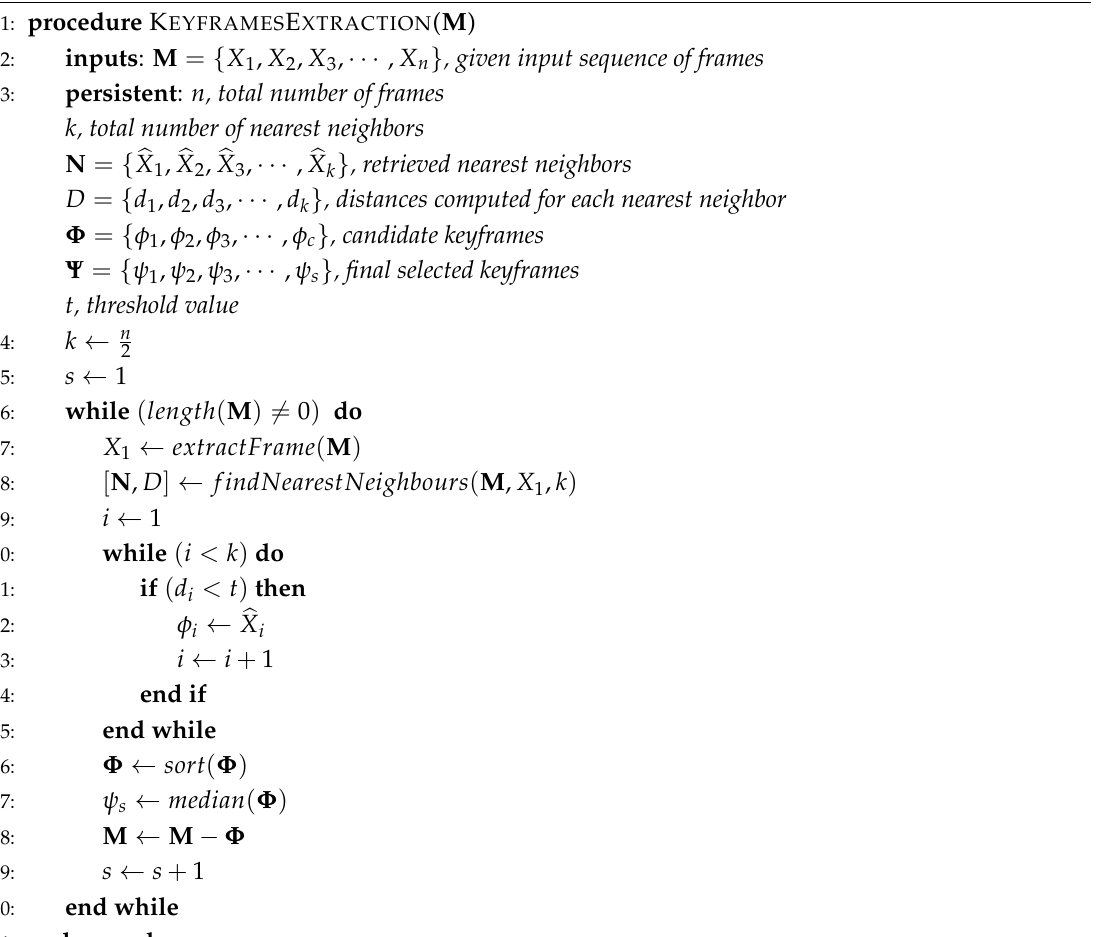
Algorithm 1 Keyframe Extraction